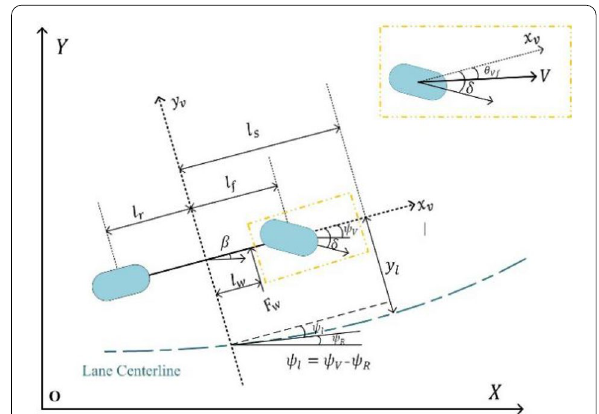
Figure 1 Schematic diagram of vehicle-road